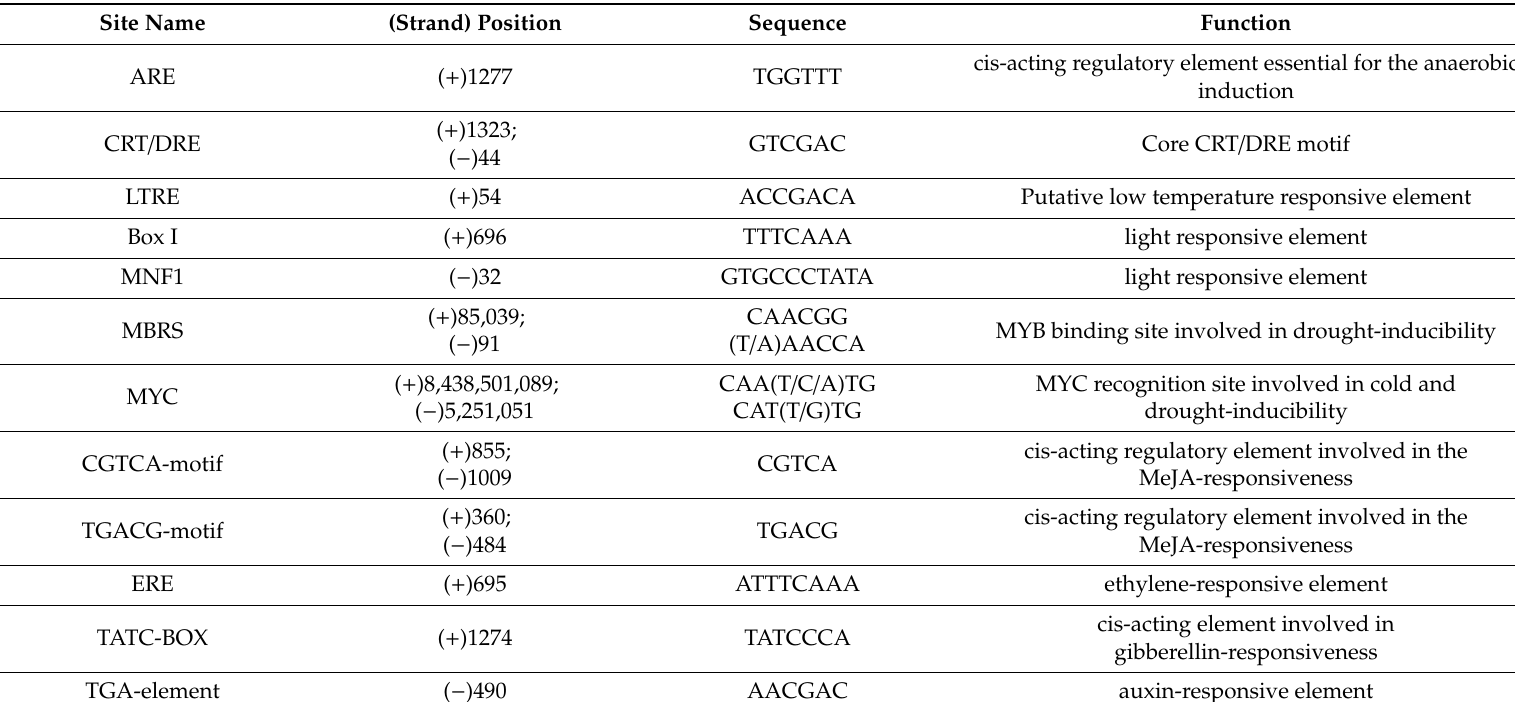
Table 1. Stress-related cis-acting regulatory elements identified in the promoter region of LlMYB3